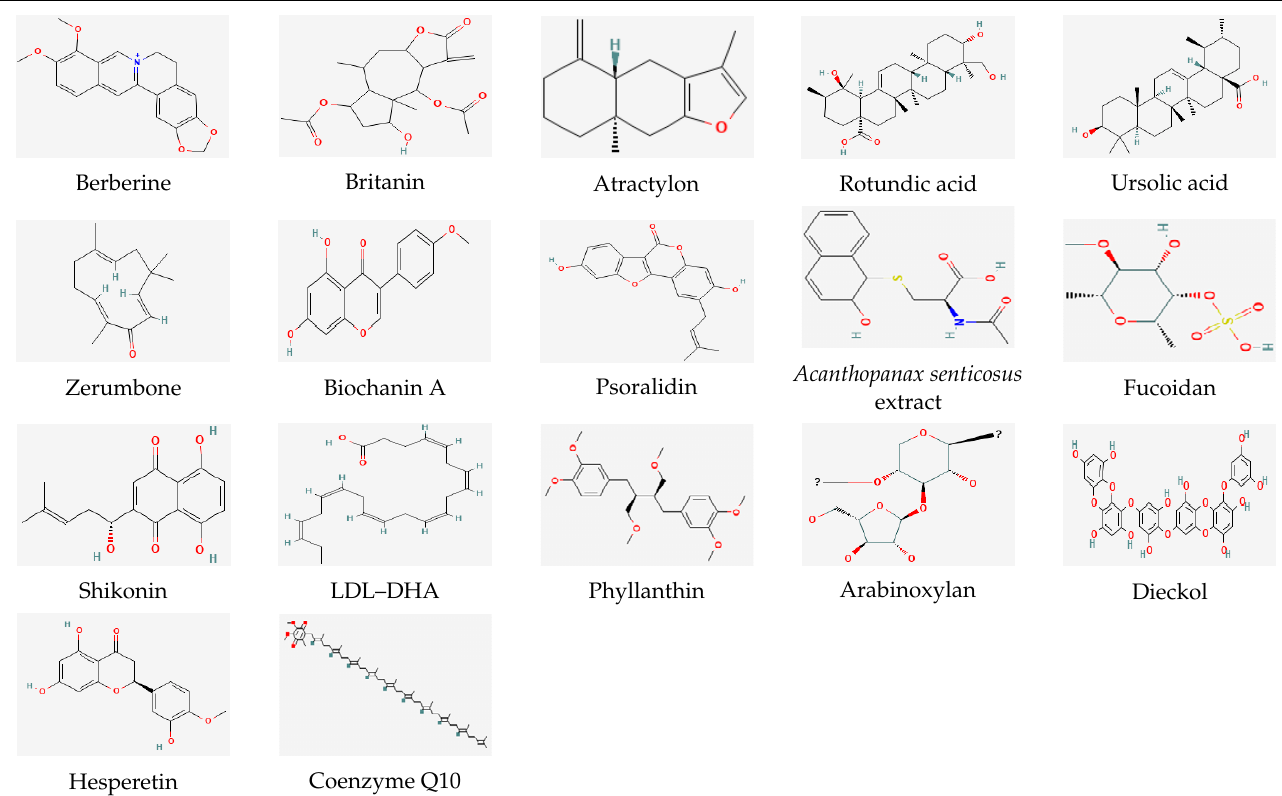
Table 5. Chemical structures of the single compounds.